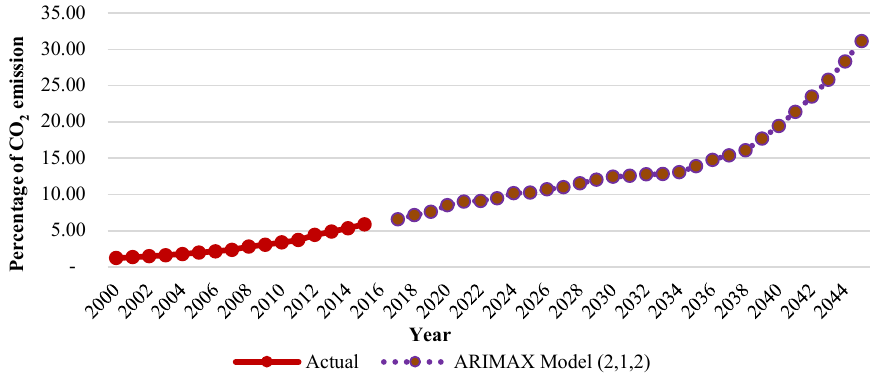
Fig. 3. Forecasting from ARIMAX Model 2